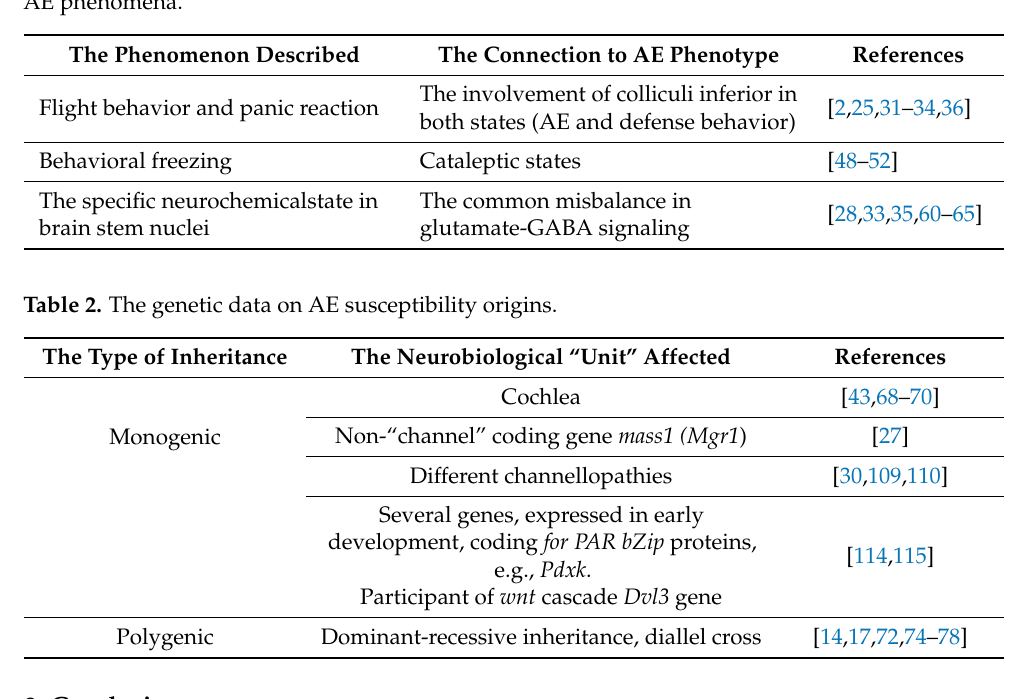
The data evidencing the neurobiological parallels between defense behavior and